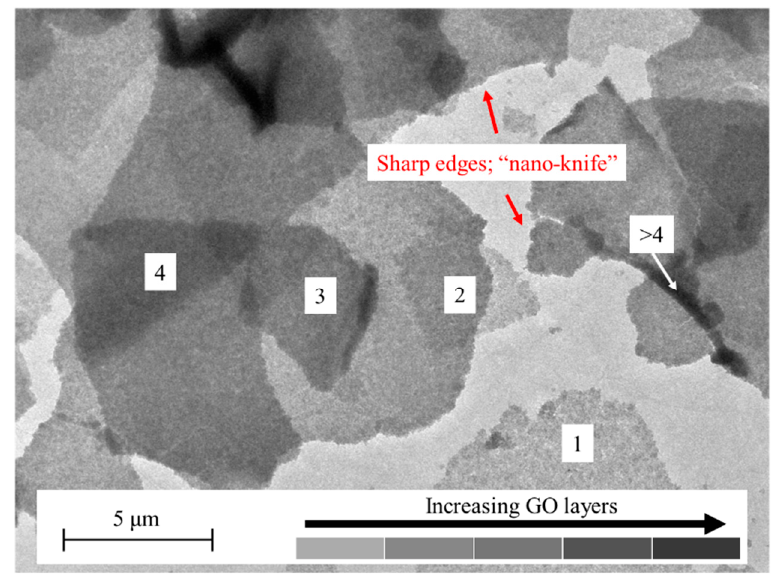
Figure 3. TEM image of the single and multiple layers of “nano-knife” GO in distilled water. Numbers in the figure represent layers of GO.